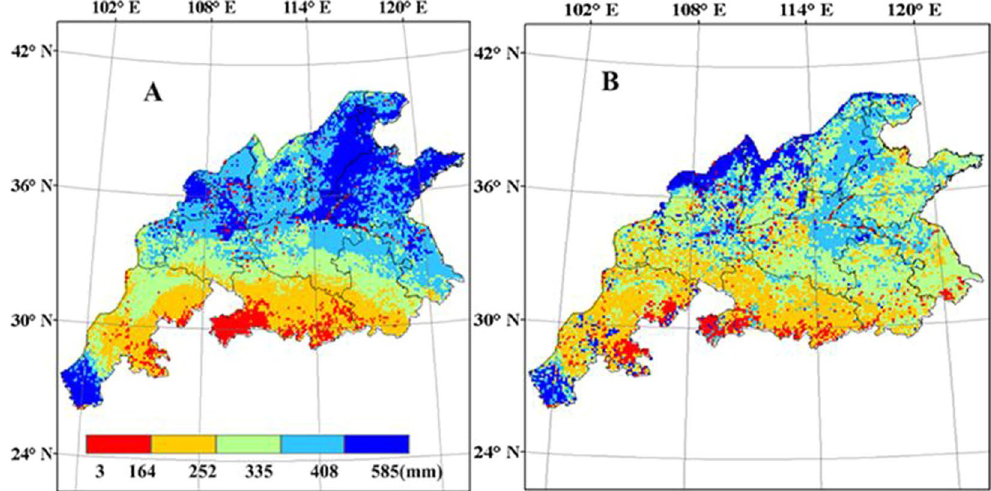
Figure 12. The average irrigation amount of winter wheat from 1998 to 2008 in the main production regions of China, ( A ) CERES-Wheat ( B ); WheatGrow (This figure was created by ArcGIS 9.3, http://www.esri.com/ arcgis/).